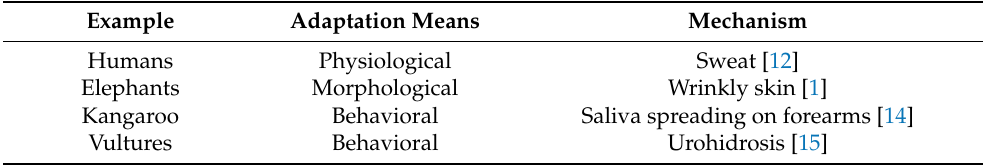
Table 1. Examples of evaporative cooling found in nature.